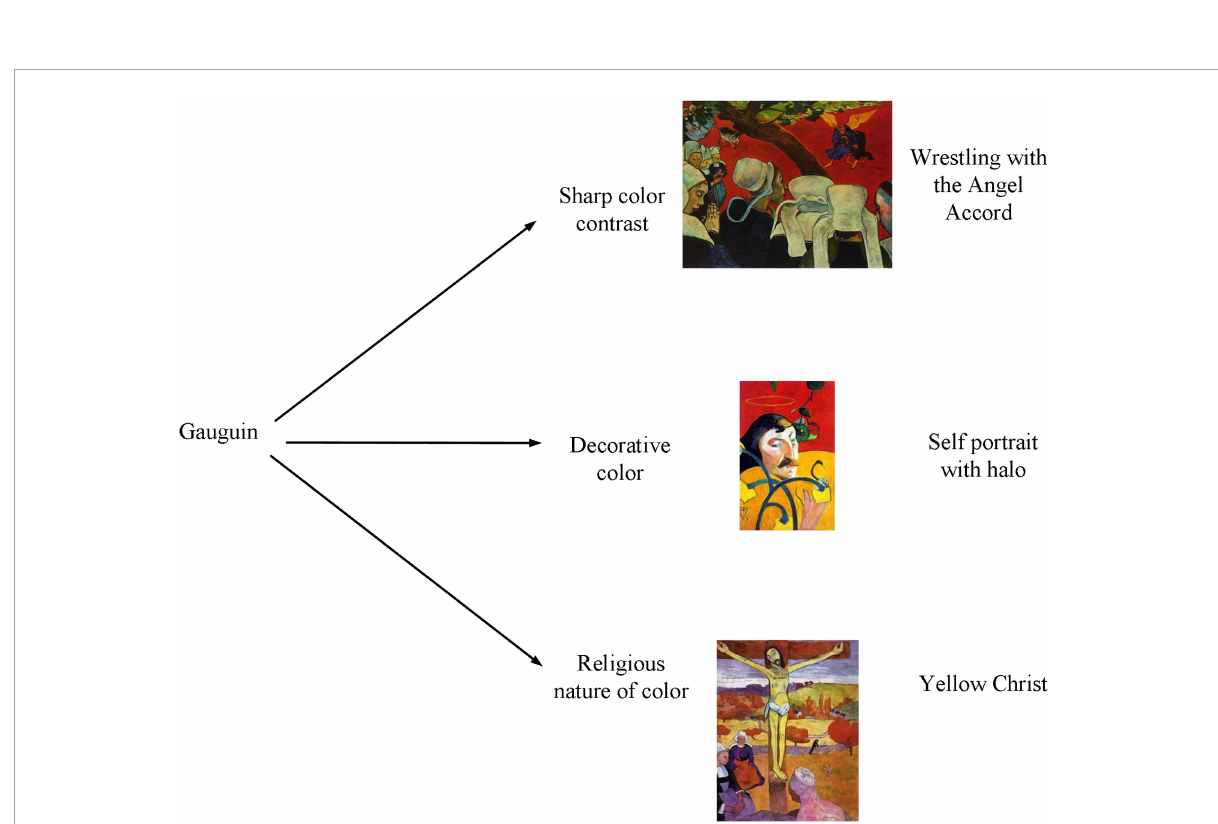
FIGURE3 Colors in Gauguin’s